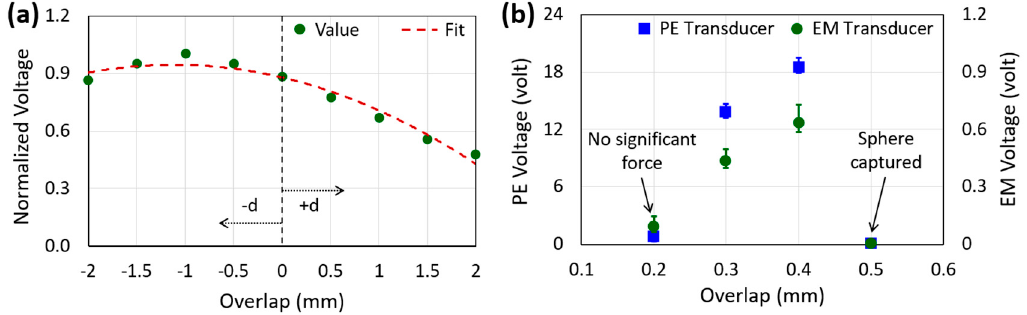
Figure 5. Normalized open circuit voltages for different magnet-coil overlaps ( a ) and open circuit voltages of the transducers for various overlaps between the freely movable sphere and the parabolic top of the proof-mass ( b ).